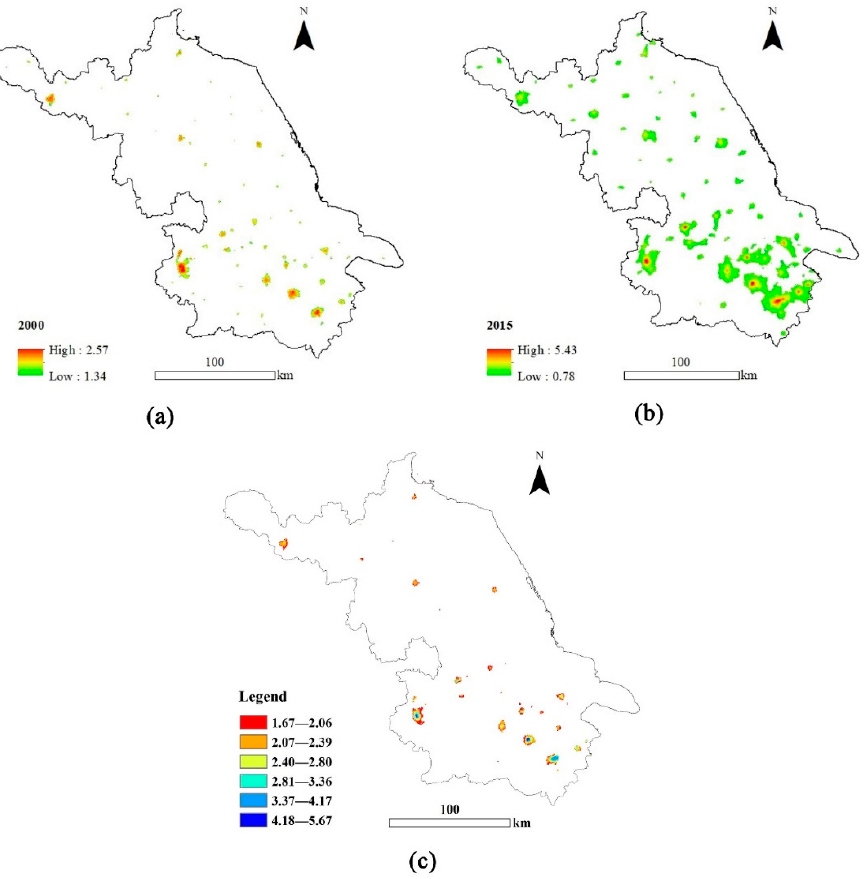
Figure 5. Spatial distribution of energy-related CE intensity ( × 10 4 t.km − 2 ) in 2000 ( a ) and 2015 ( b ), and the annual mean energy CE ( × 10 4 t.km − 2 ) ( c ).